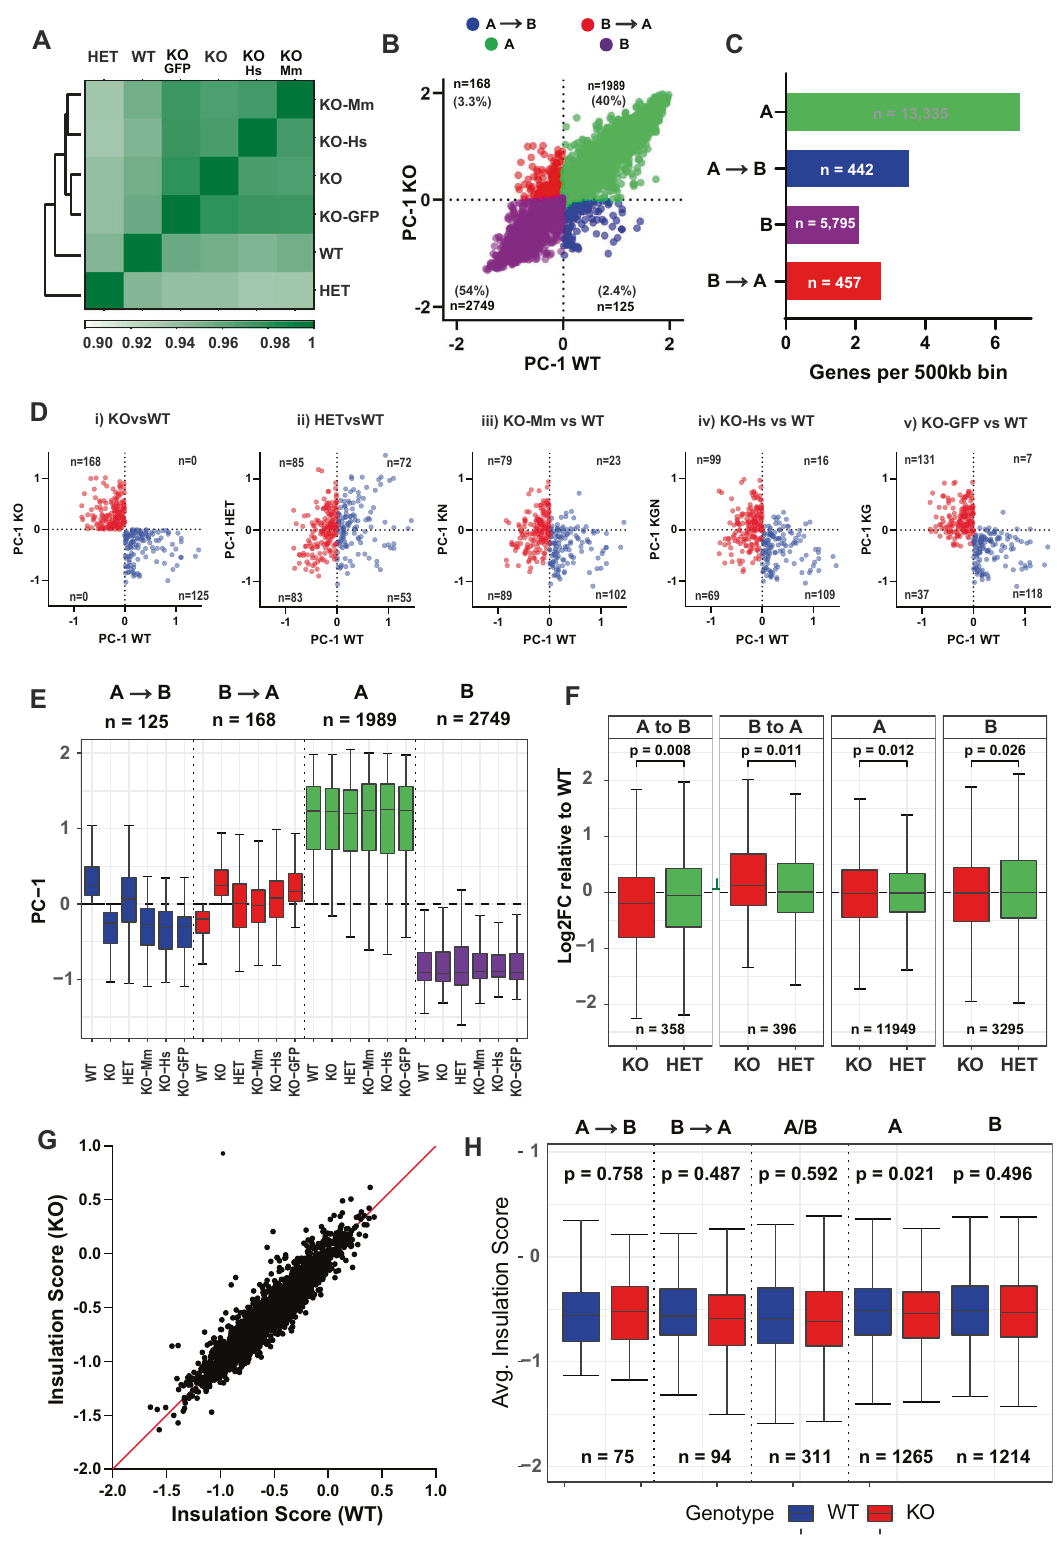
compartment switch for 18% of A → B bins and 52% of B → A human (Fig. 3D-iv) NLS- β -actin was distinctly stronger for bins bins (Fig. 3D-iii). Reintroduction of human β -actin produced that were activated upon β -actin depletion (lower left quadrant) similar levels of compartment rescue (Fig. 3D-iv), while negative than bins that were repressed upon β -actin depletion (upper right controls expressing GFP showed little or no change (Fig. 3D-v). quadrant). While the reason for this is not clear, based on our Unexpectedly, compartment rescue by mouse (Fig. 3D-iii) or ATAC-Seq and ChIP-Seq data, we speculate that the repressed NATURE COMMUNICATIONS| (2021) 12:5240